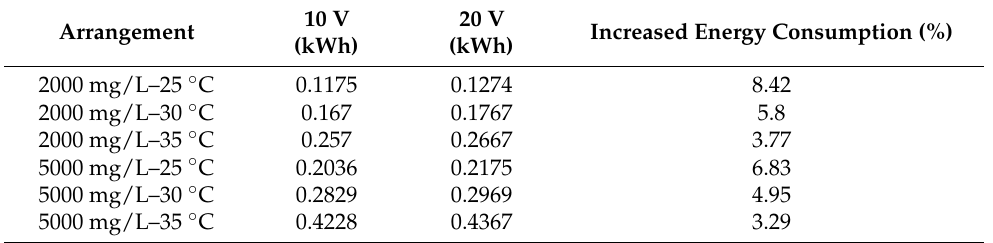
Table 10. Average total energy demand for each test.